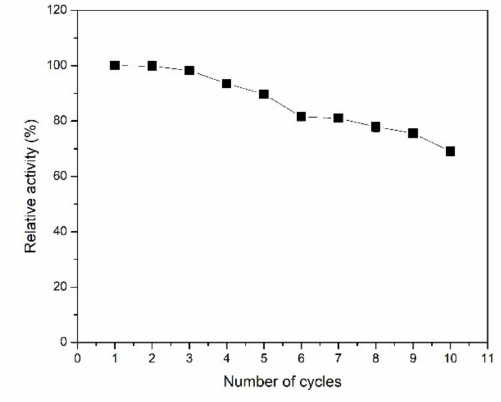
Figure 6. Reusability of XynB2 Y509E